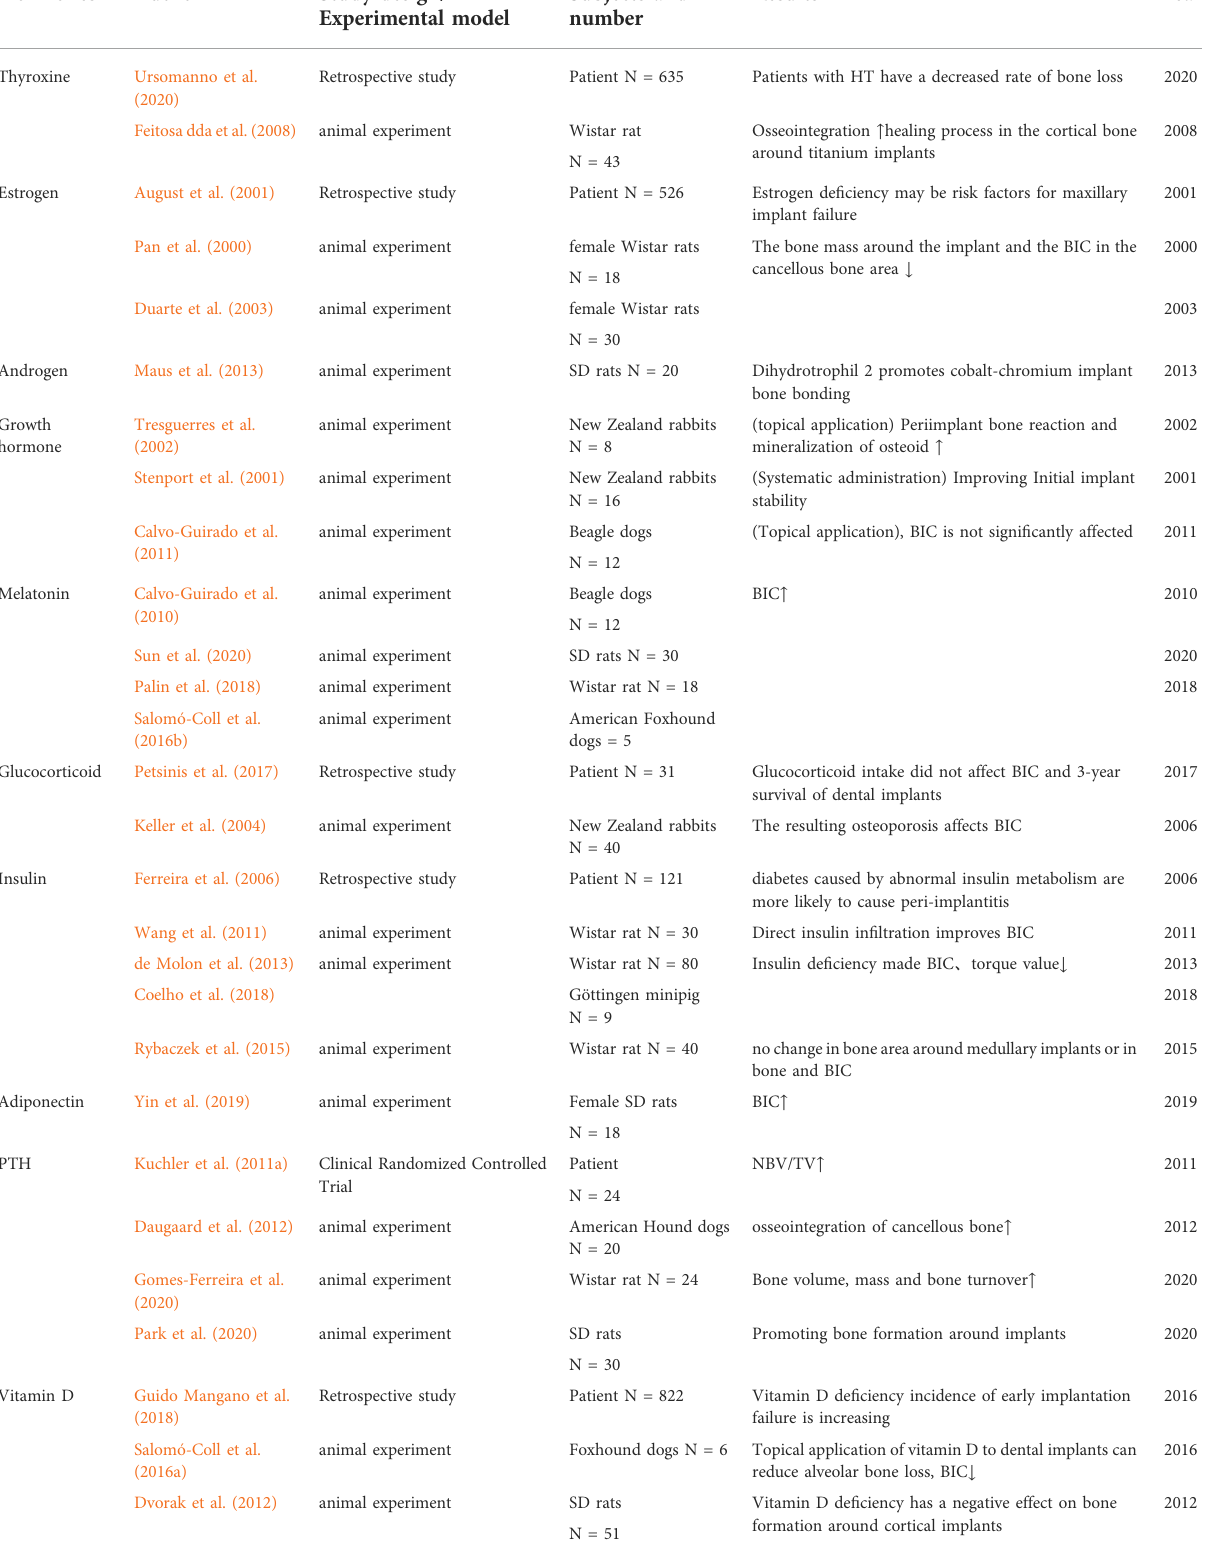
TABLE 1 Animal experiments and/or clinical case evidence related to implants and hormones in the past 2